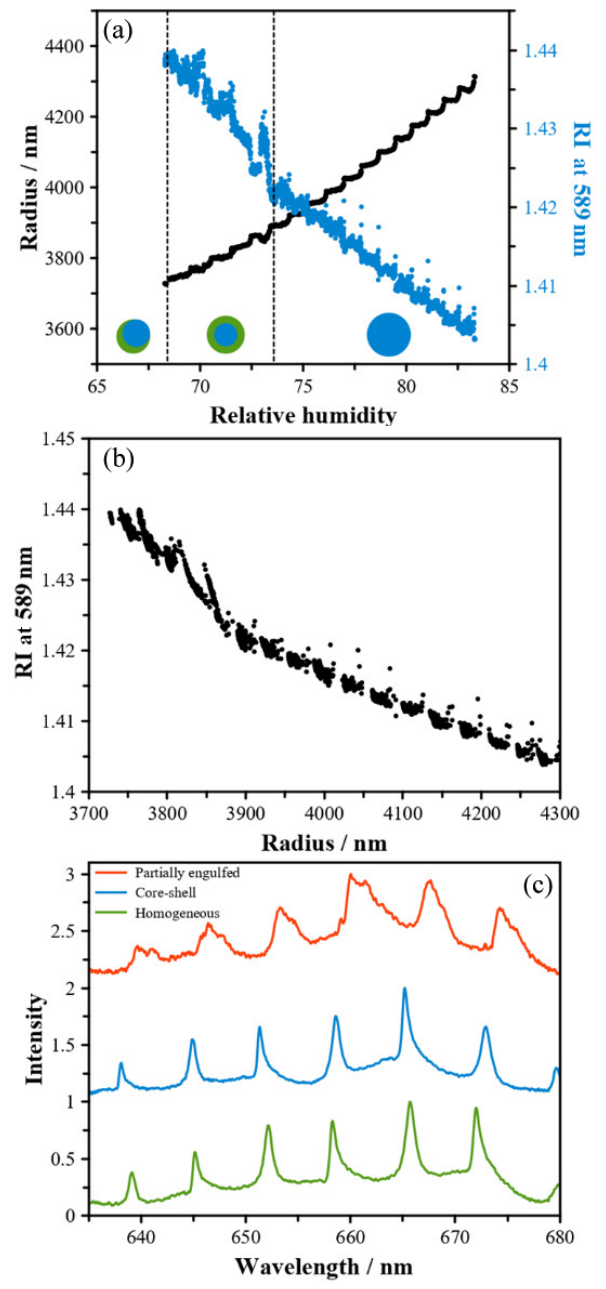
Figure 3. (a) Radius (black) and refractive index (blue) of an aque- ous 3-MGA/AS droplet (OIR = 1) levitated in a LQ-EDB as a func- tion of RH upon dehumidification at a temperature of 298K; (b) the RI as a function of radius as the RH is decreased. LLPS is identi- fied as a discontinuous change in the slope of these data; (c) Mie resonance spectra of an aqueous 3-MGA/AS droplet levitated in a LQ-EDB recorded prior to LLPS (green), following LLPS to form a core–shell morphology (blue) and following formation of a partially engulfed morphology (red).